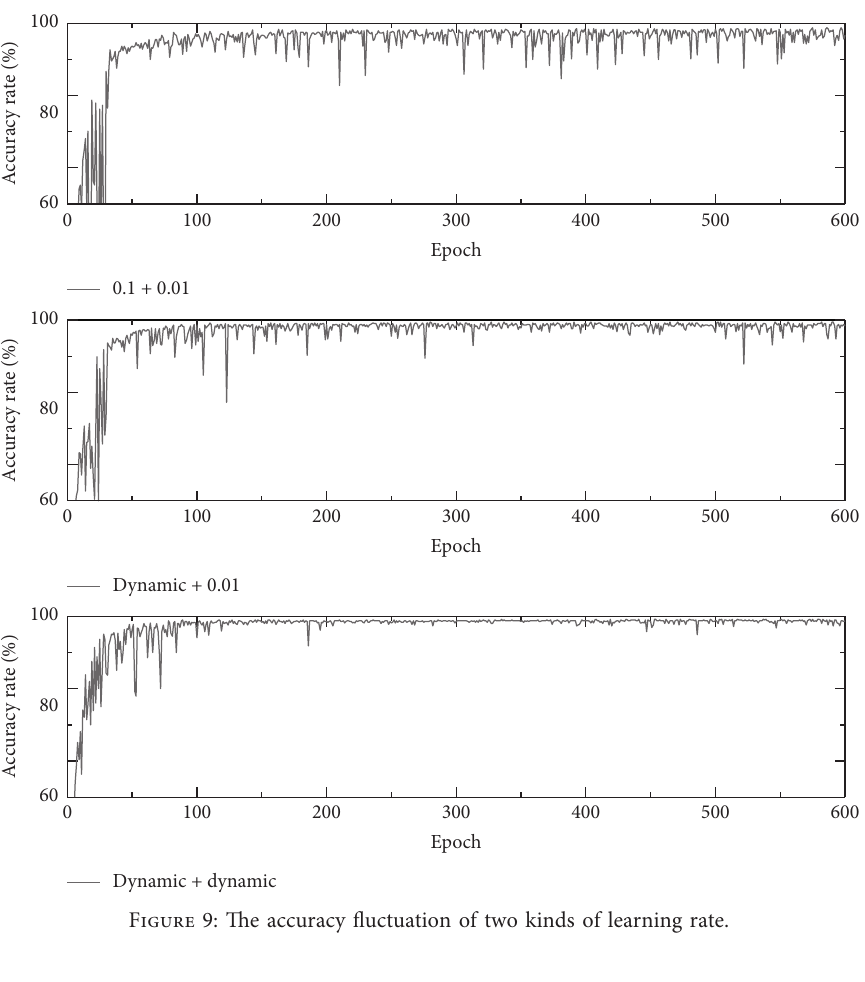
Figure 9: The accuracy fluctuation of two kinds of learning